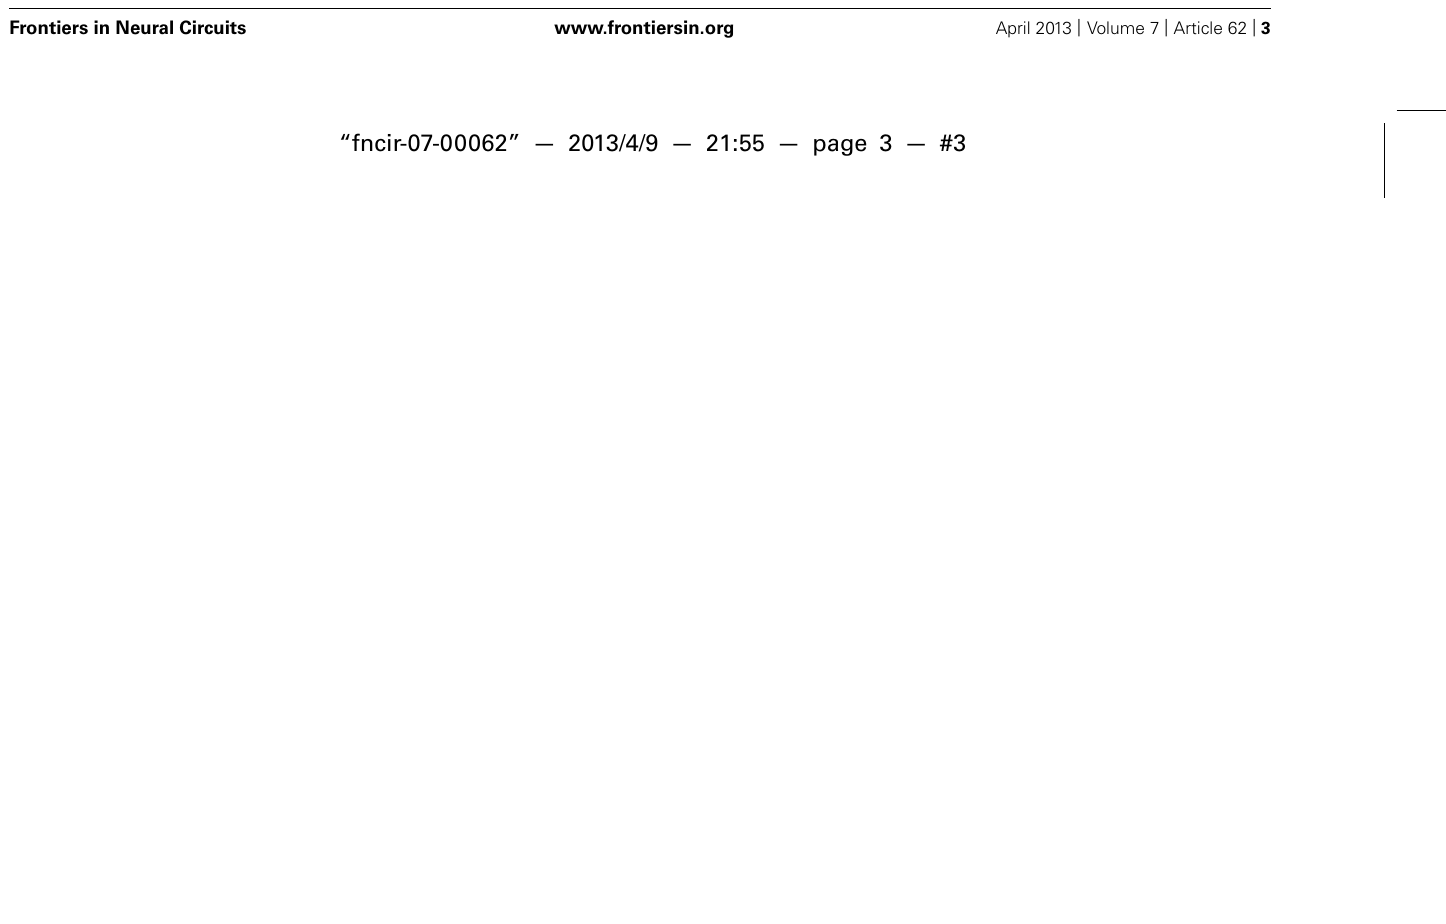
FIGURE 1 | Organization of the olfactory bulb network. Odorants are detected in the olfactory epithelium by three types of sensory neurons (microvillous, ciliated, and crypt cells) that project to different glomeruli located in different areas of the olfactory bulb. Ciliated cells mainly project to the dorsal and medial olfactory bulb; microvillous cells project to the lateral olfactory bulb (Sato etal., 2005, 2007). Crypt cells project to a dorsomedial domain in zebrafish and to a ventral domain in carp (Hamdani el and Doving, 2006; Gayoso etal., 2012). In each glomerulus, olfactory sensory